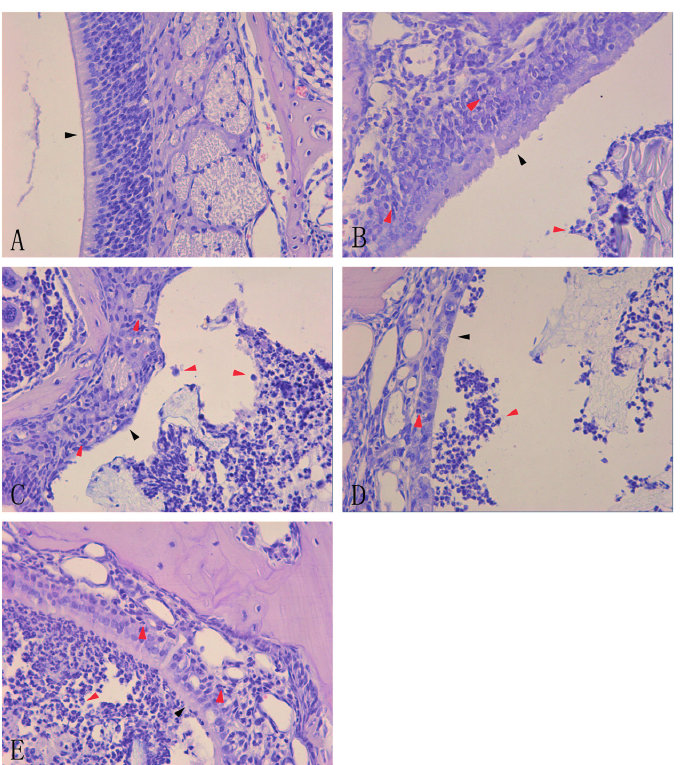
Figure 1. Hematoxylin-eosin staining of nasal mucosa of acute rhinosinusitis induced by Staphylococcus aureus . Control mice remained un-inoculated ( A ). C57BL/6 mice were inoculated in the right nasal cavity with a suspension of S. aureus (10 μ L 1.2 × 10 9 CFU/mL) and the inflammation was analyzed after 1 day ( B ); 3 days ( C ); 7 days ( D ); and 14 days ( E ). Histological analysis of leukocyte infiltration and morphological analysis of the nasal mucosa in the nasal cavity of mice were carried out by staining with hematoxylin-eosin (×40). The red arrows indicate infiltrated cells, and the black arrows indicate the damage to the nasal mucosa in images ( B ), ( C ), ( D ), and ( E ) and control nasal mucosa in image ( A